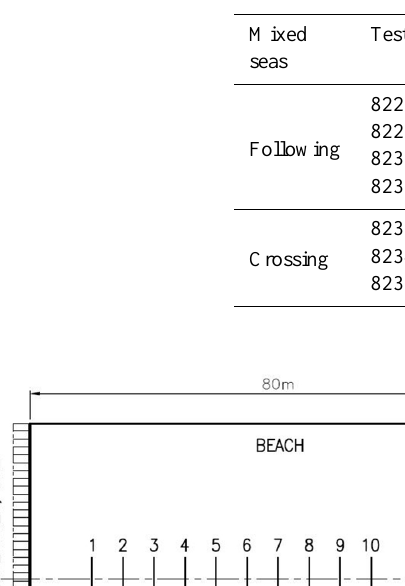
Table 1. Target characteristics of the mechanically generated bimodal sea states.